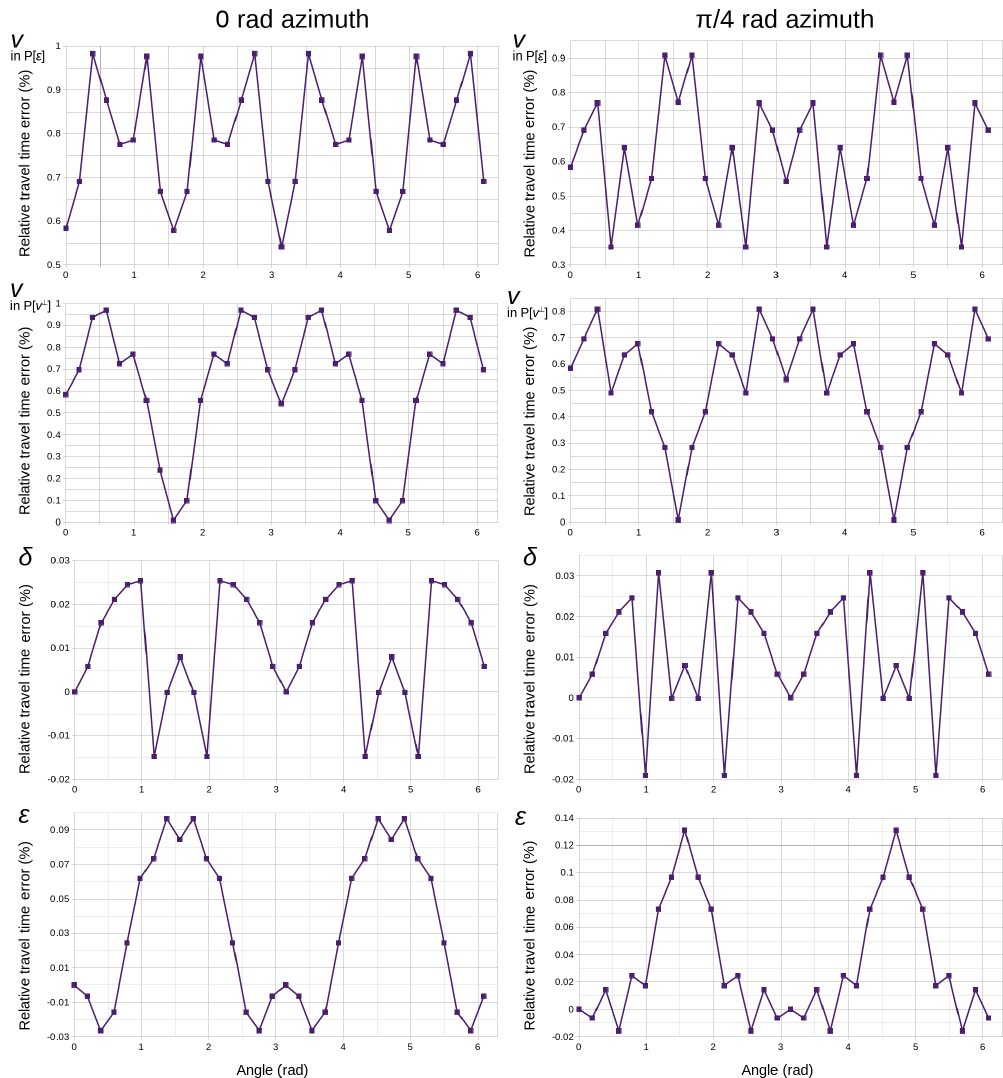
Figure 3. For both selected meridians, 0 rad and π/ 4 rad azimuths, relative travel-time errors in percentage with respect to the analytic value for each of the four simulations used in the sensitivity analysis. Polar angle origin is in the downward vertical axis. Mean values and deviations are shown in Table